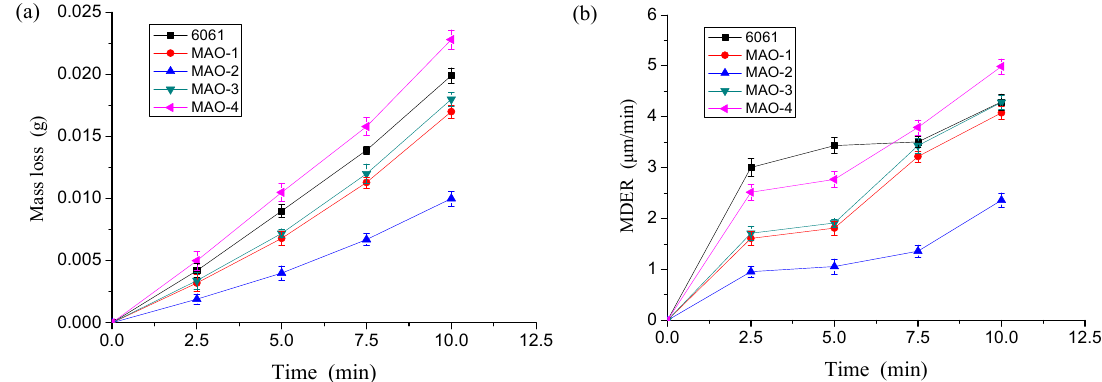
Figure 2. The test curves of the five samples. ( a ) Mass loss, ( b ) mean depth of erosion (MDER).